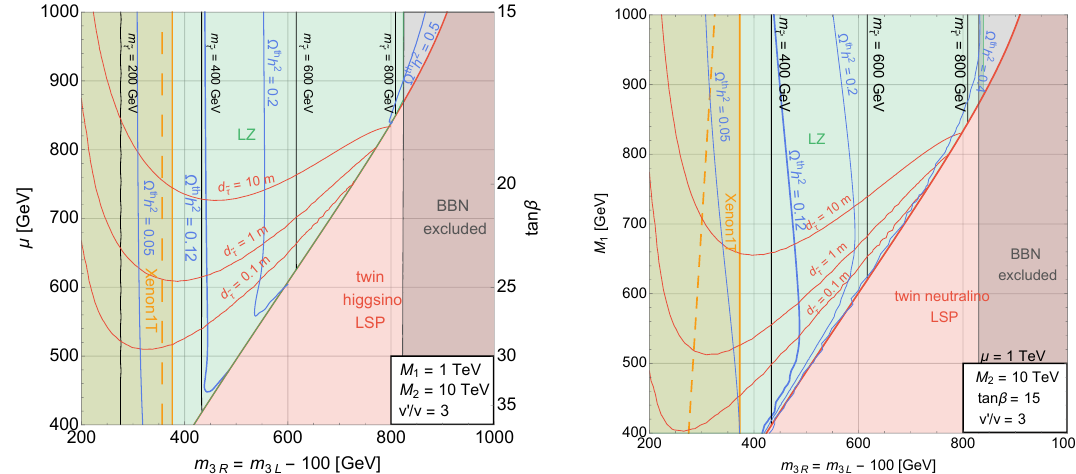
Figure 4. Contours of Ω th h 2 (blue lines) and the twin stau LSP mass (black line) in the plane ( m ) for tan β = 15 TeV /µ (right axis) and M = 1 TeV (left panel) and in the plane ( m ) 3 R , µ 1 3 R , M 1 for µ = 1 TeV and tan β = 15 (right panel). The remaining parameters are set to m = m + 3 L 3 R 100 GeV, v 0 /v = 3 , and M = 10 TeV. In the red region the twin Higgsino (bino) is the LSP in the 2 left (right) panel. The yellow and green regions are defined in the same way as in figure 3. The red contours show the stau decay length d assuming Higgsino mixing (cid:15) = 20 GeV ( v 0 /v ) / 3 , which is ˜ τ H typical in D-term Twin Higgs models. The mixing may be larger by an O (1) factor.